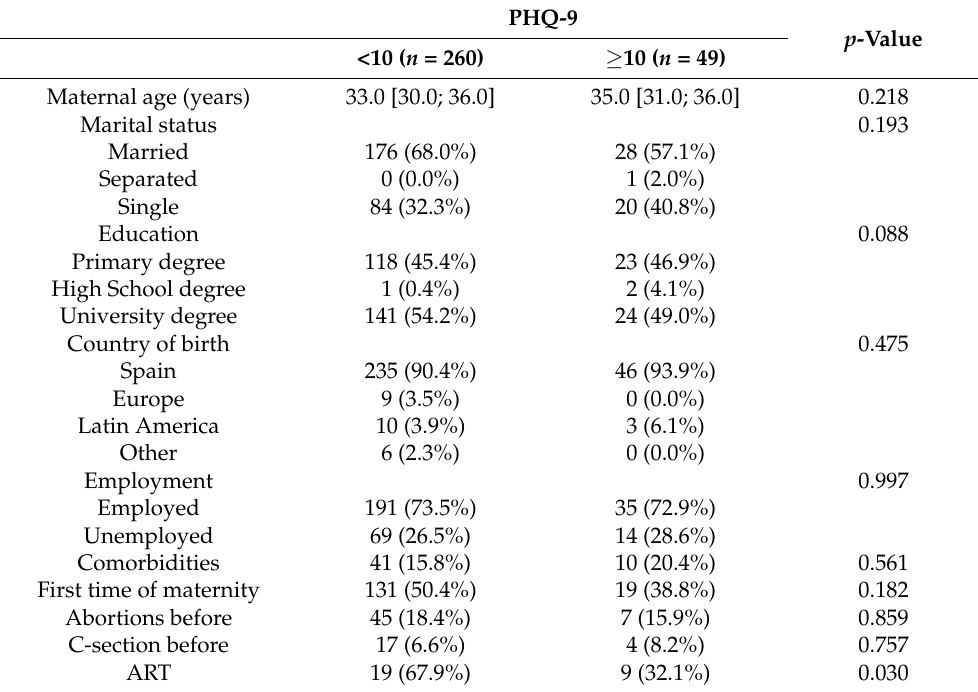
Table 2. Sociodemographic characteristics compared to depression scale.